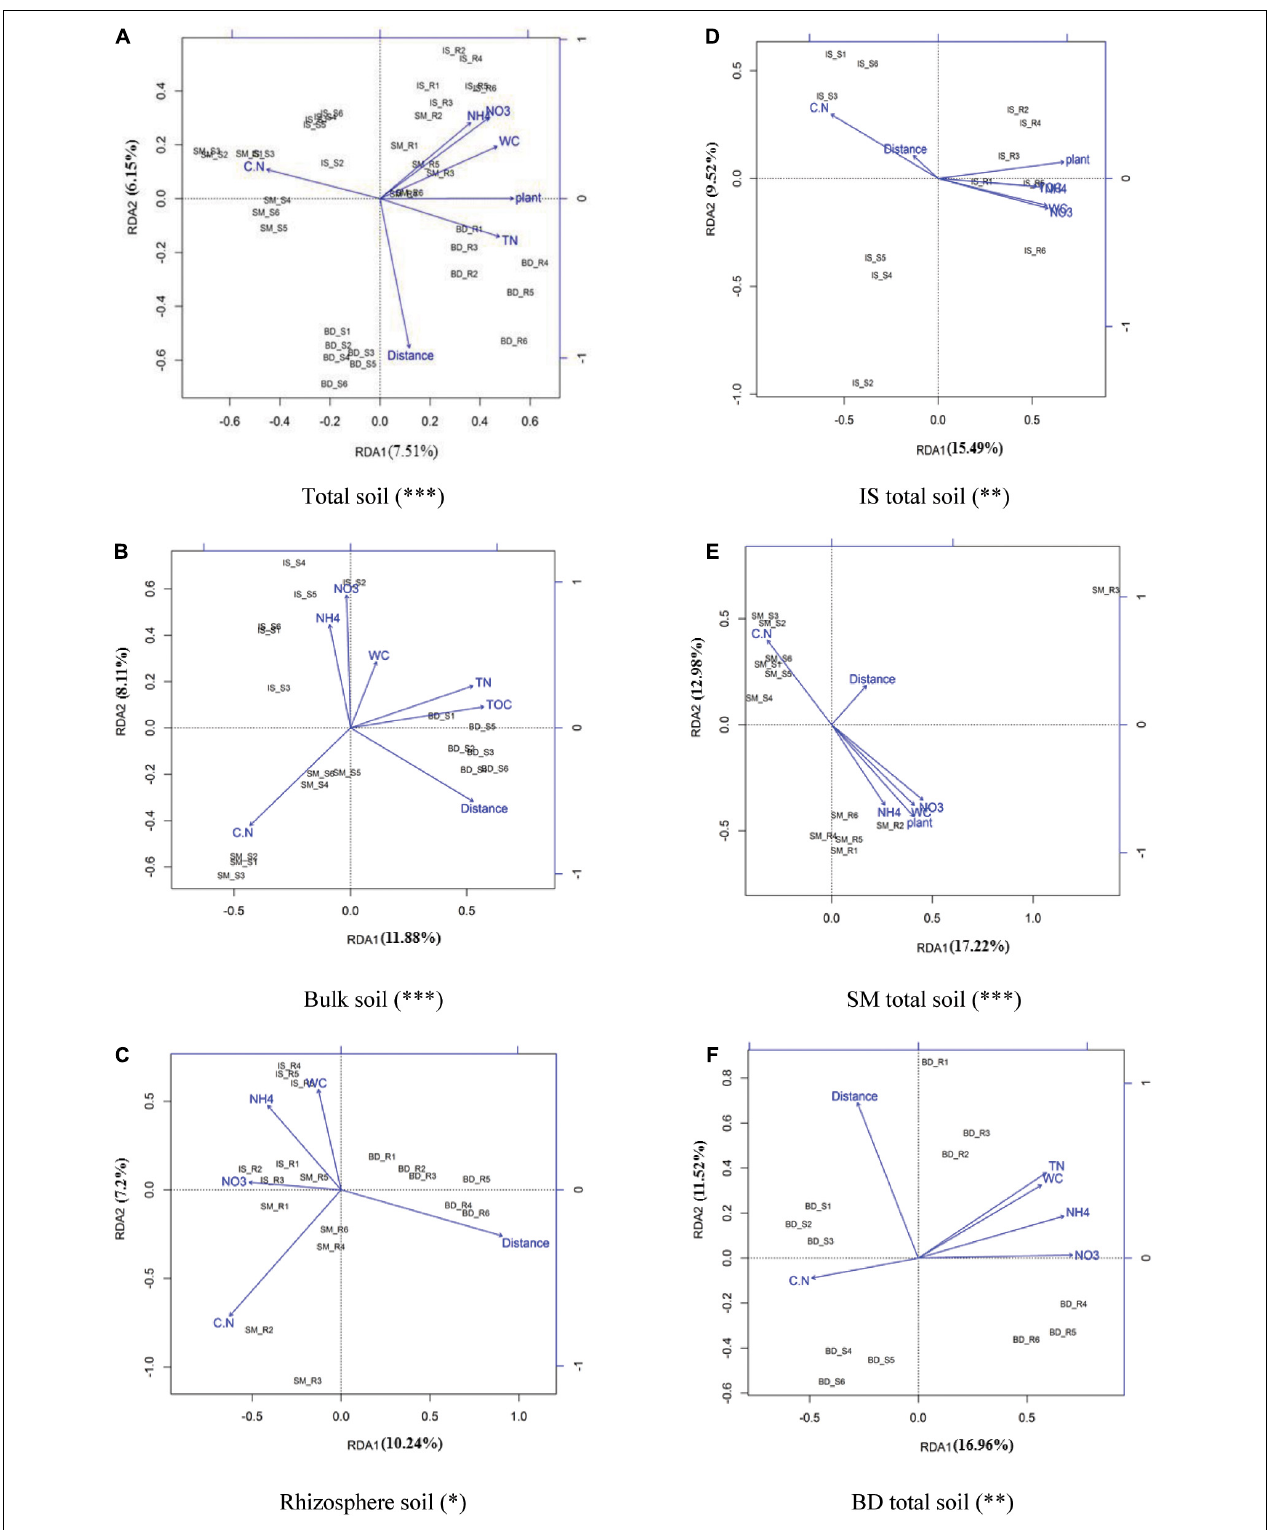
FIGURE 6 | Bacterial community and environment factor RDA analysis. (A) For total soil, (B) for bulk soil, (C) for rhizosphere soil, (D) for IS total soil, (E) for SM total soil, and (F) for BD total soil. Sites: IS, middle of glacier terminal and small Qiangyong lake; SM, midway along the edge of the smaller lake; BD approximately one-third of the way along the edge of the larger lake. Significance: ***0.001; **0.01; and *0.05. C:N, total Carbon to total Nitrogen ratio; WC, water content.